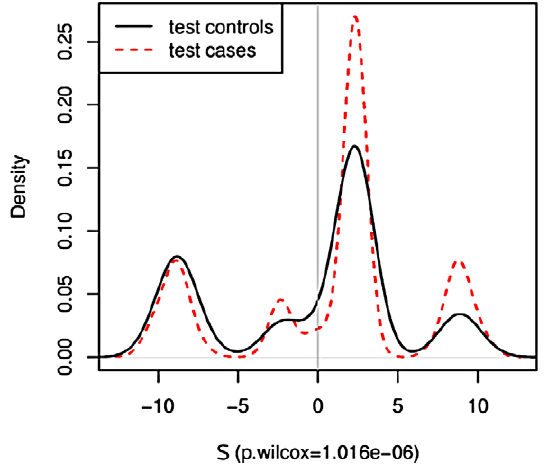
Figure 2. PoDA applied to four highly-significant SNPs. Shown is the distribution of S values in CGEMS cases (red) and controls (black) for a SNP-set comprised of four highly-significant SNPs located in the FGFR 2 gene [4]. As expected, there is a substantial difference in case and control S values, with the cases having higher S (i.e., closer to other cases) than controls. The discreteness of the distributions are due to the fact that with four SNPs, a finite number of S values are possible.